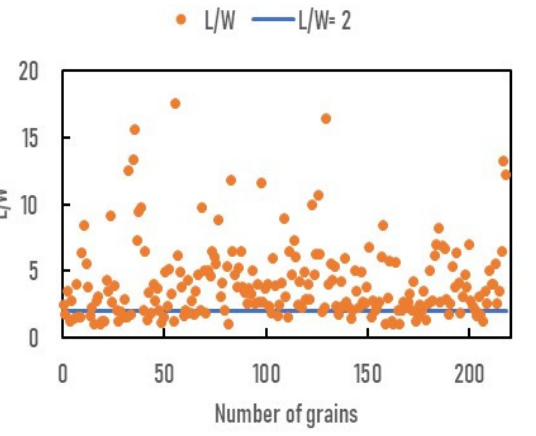
Figure 10. Equiaxed grains between the columnar grains; Length from bottom of sample ( a ) 50 mm; ( b ) 55 mm.